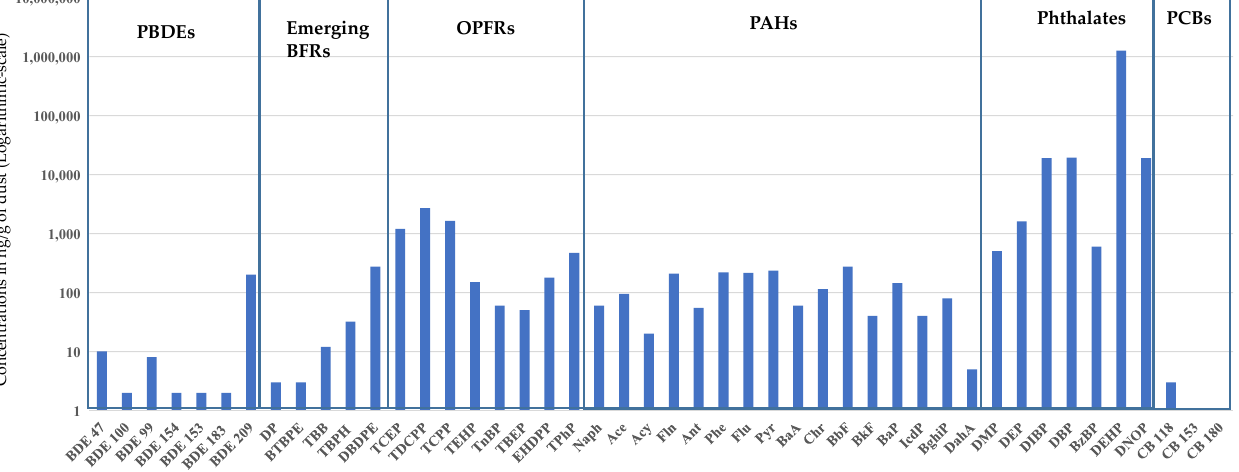
Figure 2. Profile of individual analyzed chemicals in Saudi car dust. The concentration (ng/g) on y -axis is in a logarithmic scale.